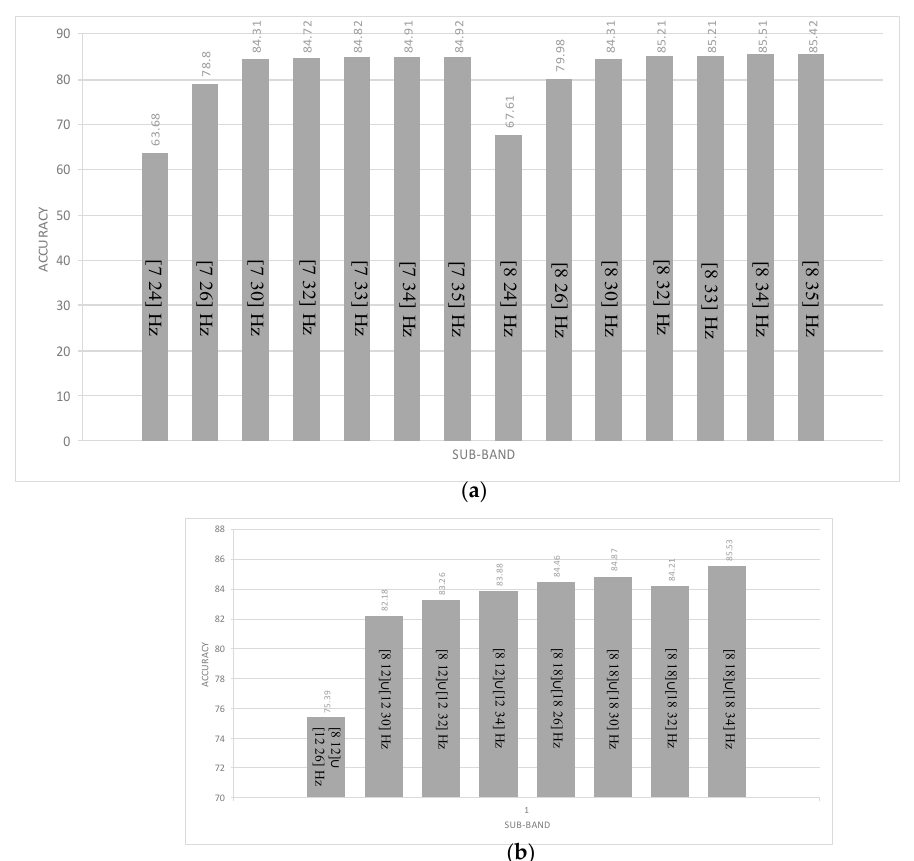
Figure 3. The effects of frequency bands on the classification accuracy. ( a ) Effect of the offset and time window variation on the accuracy using fast Fourier transform (FFT); ( b ) Effect of the frequency band variation on the on the accuracy using autoregressive (AR) model. Table 4. Multi-class LDA and SVM classification accuracy results.